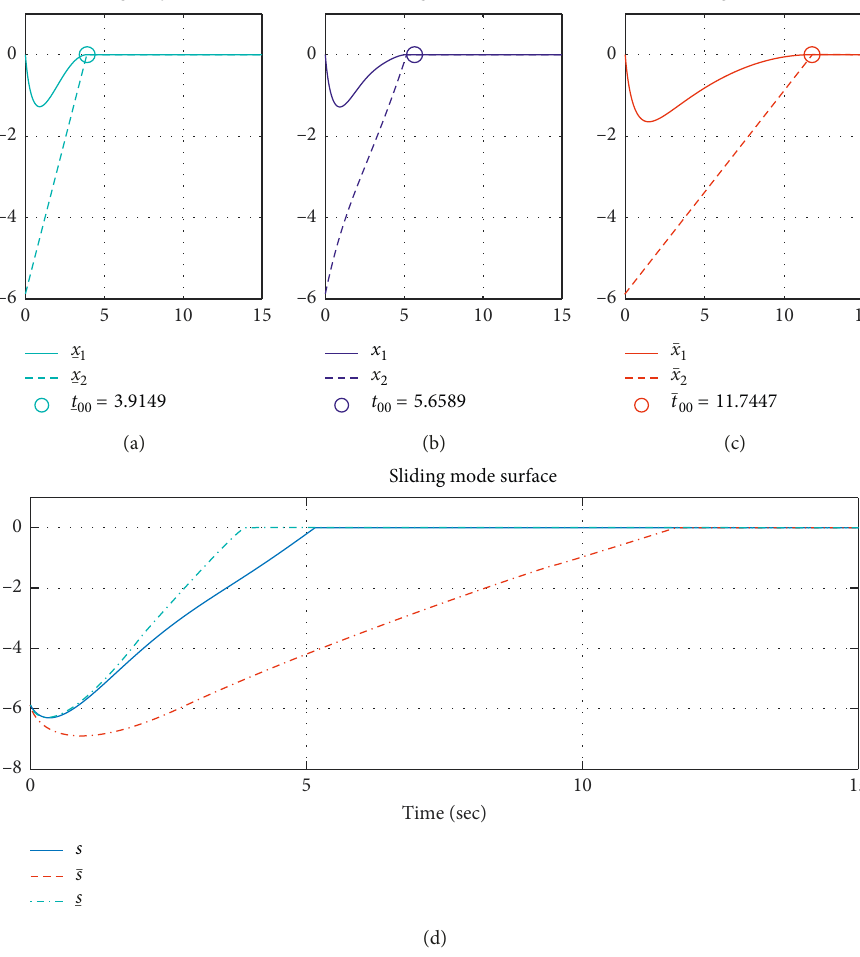
Figure 11: Finite-time convergence of the output and sliding mode